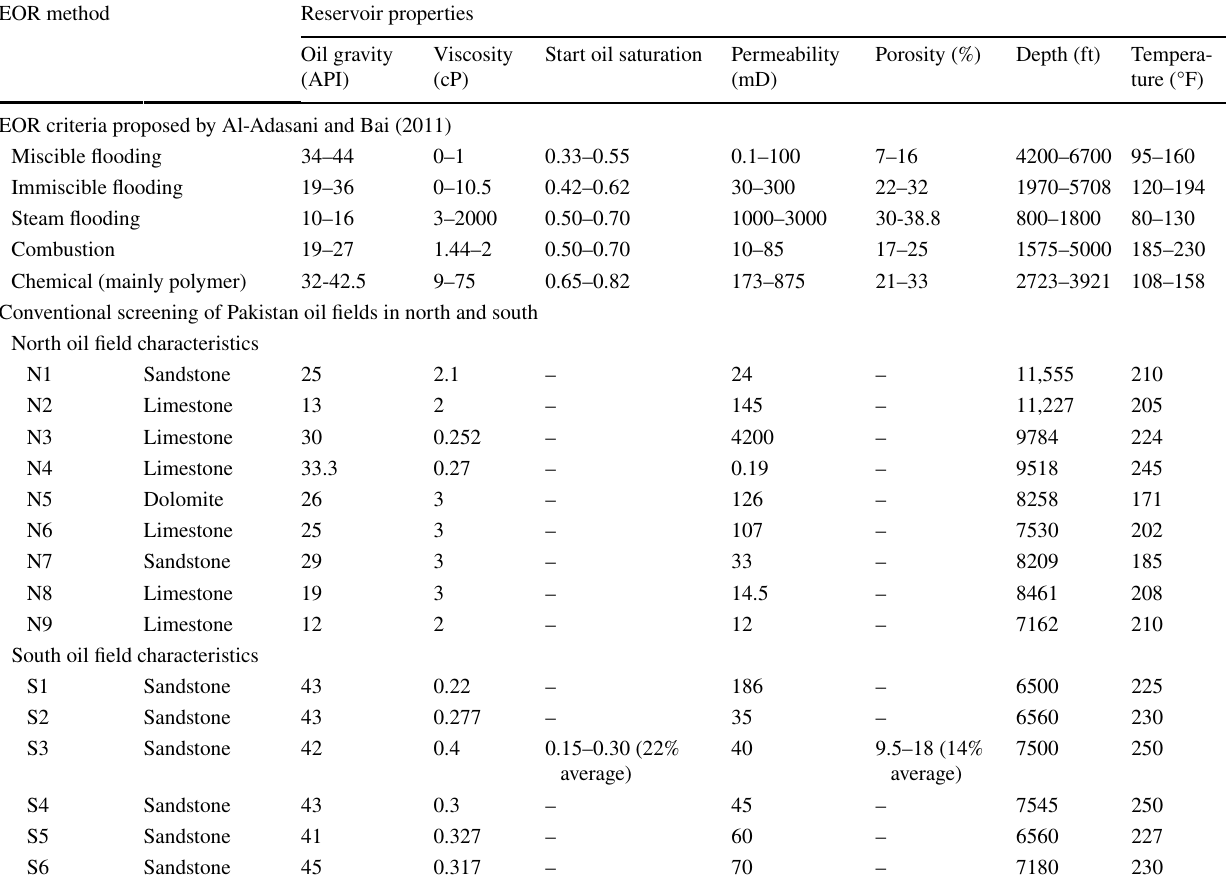
Table 2 Implementation of screening criteria by Al-Adasani and Bai (2011) on Pakistan oil reservoirs for selection of EOR method EOR